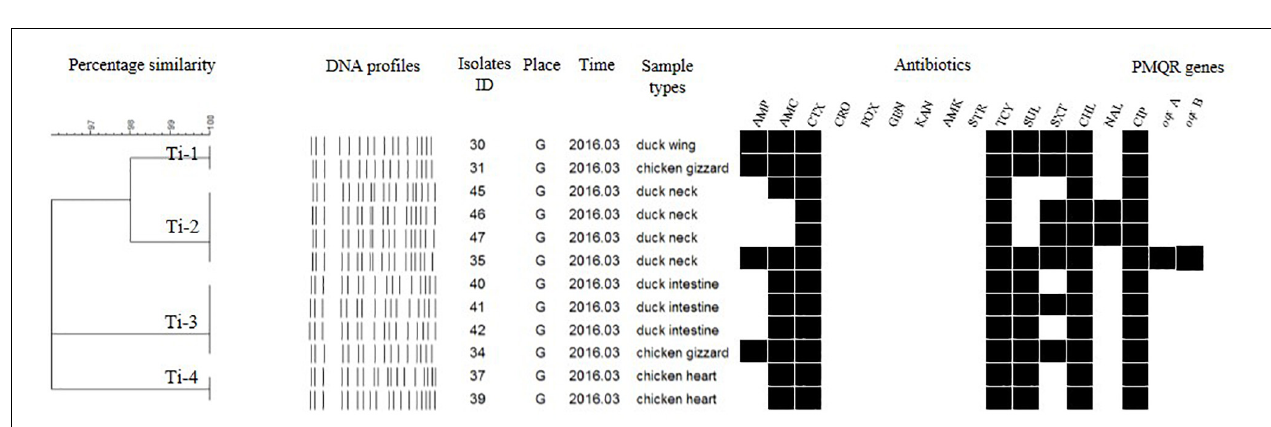
FIGURE 6 | Dendrogram of PFGE profiles for eight S. Albany isolates, their antibiotic resistance, and PMQR genes. Antibiotics: Ampicillin (AMP), Amoxicillin-clavulanic acid (AMC), Ceftiofur (CTX), Ceftriaxone (CRO), Cefoxitin (FOX), Gentamicin (GEN), Kanamycin (KAN), Amikacin (AMK), Streptomycin (STR), Tetracyclines (TCY), Sulfisoxazole (SUL), Trimethoprim/sulfamethoxazole (SXT), Chloramphenicol (CHL), Nalidixic acid (NAL), and Ciprofloxacin (CIP).